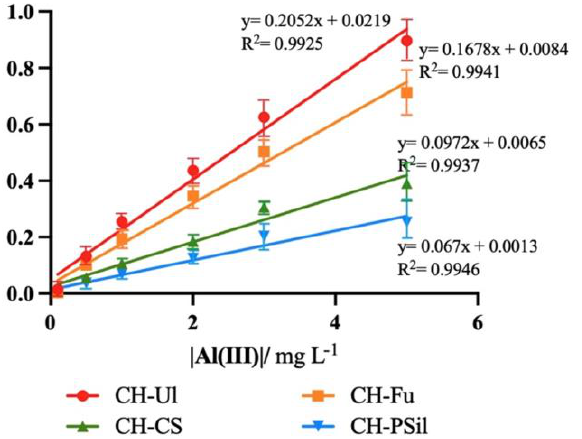
Figure 8. Calibration curves with the different membranes for 0.1 to 3 mg L −1 of Al(III) with